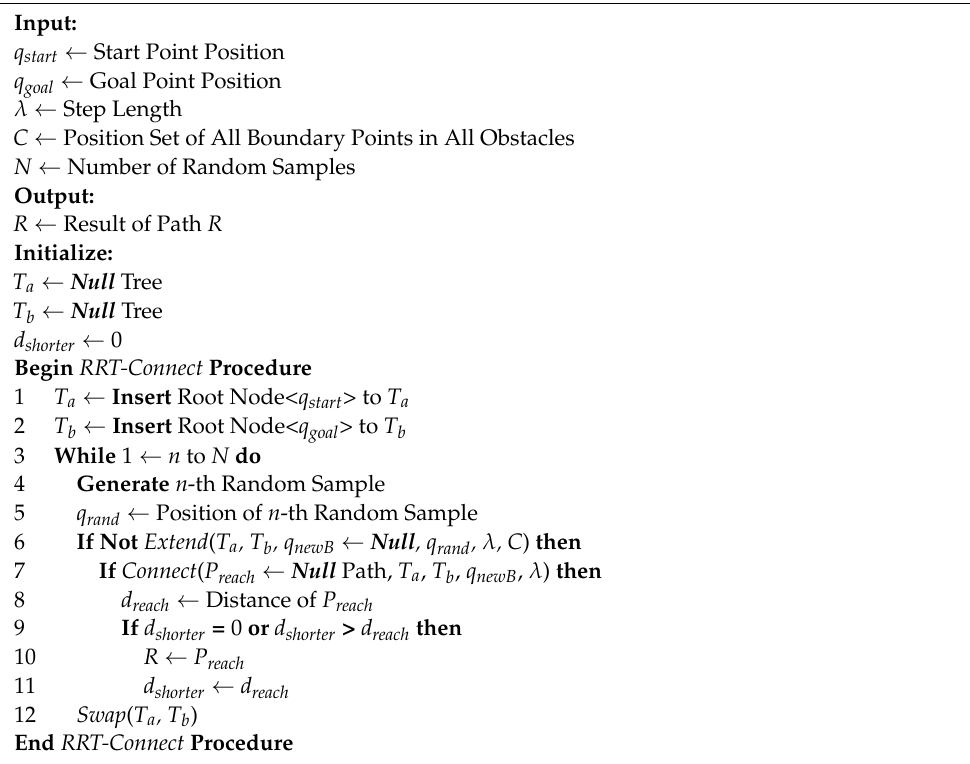
Algorithm 1 Pseudocode of the RRT-Connect